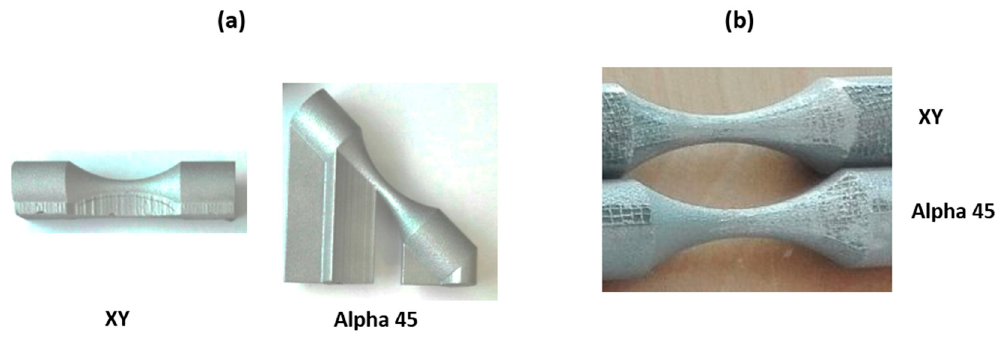
Figure 2. ( a ) Raw sample extracted from the platform, ( b ) fatigue sample after support removal and before thread